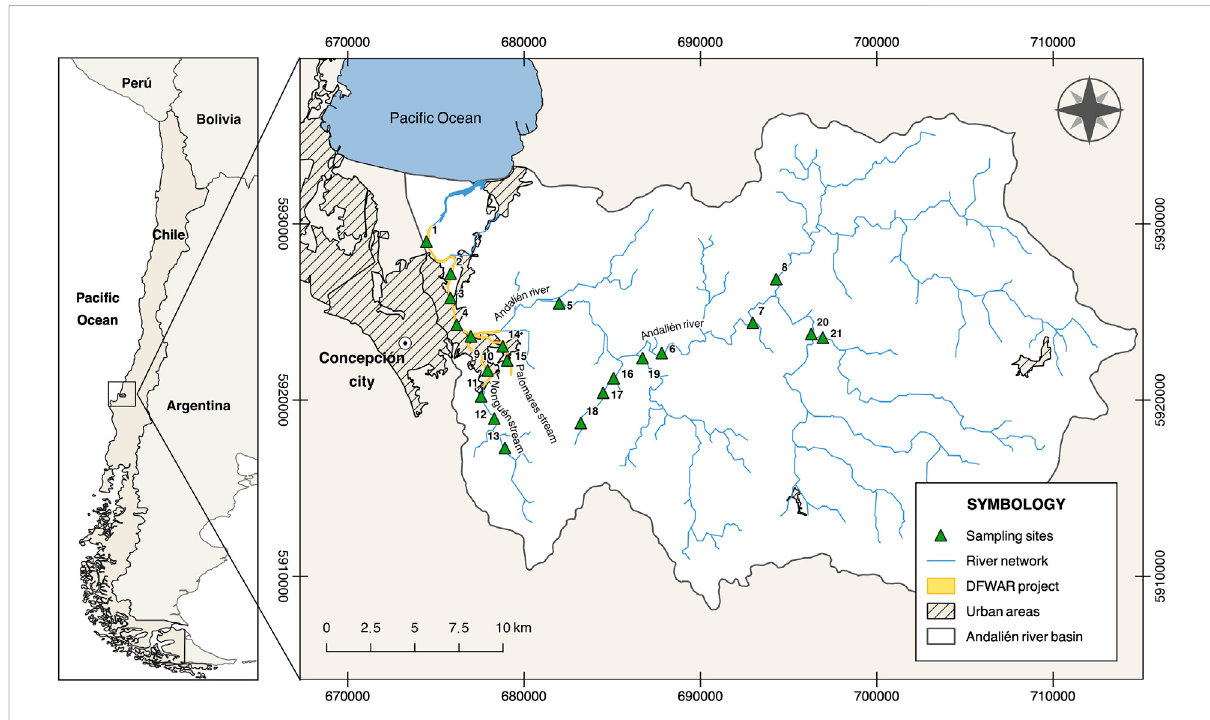
FIGURE 1 Andalién River basin and locations of all sampling sites with fi sh data. The channelization zone is shown in